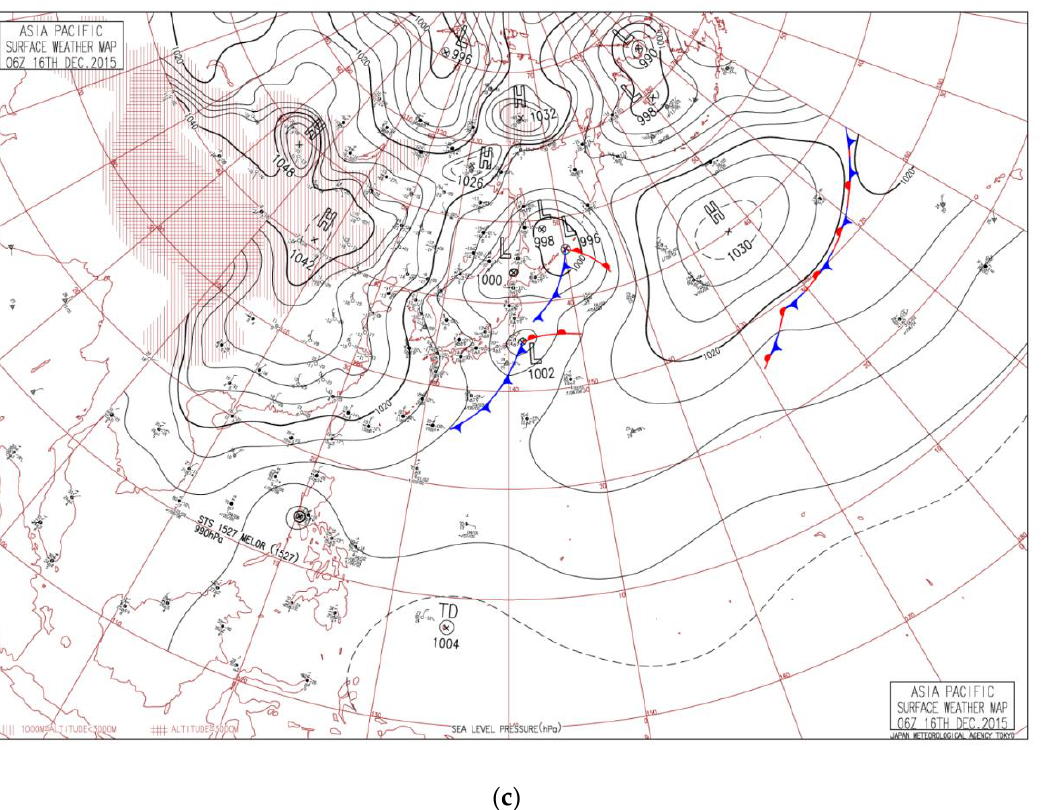
Figure 6. Surface weather map of East Asia: ( a ) at 20:00 LST on 17 January 2015; ( b ) at 20:00 LST on 5 February 2015; ( c ) at 14:00 LST on 16 December 2015. During period two, at 20:00 LST on 4 February, air pressure at the CHPS centre was 1056 hPa, located in Mongolia (49 ◦ N, 94 ◦ E) at BE2. It then moved toward the east–southeast. At 12:00 LST on 5 February, the maximum C PM in the Taipei metropolis 2.5 was 94.2 µ g · m − 3 (Figure 7b). At 20:00 LST, air pressure at the CHPS centre decreased to 1032 hPa, located in the Hubei Province (31 ◦ N, 115 ◦ E) at E2 (Figure 6b). It then moved further toward the east-southeast. At 08:00 LST on 6 February, air pressure at the CHPS centre decreased to 1030 hPa, located in the Jiangxi Province (29 ◦ N, 118 ◦ E) at AE2. It then moved slowly toward the east. At the three stages, apart from ∆ θ , T m , RH, WS, MH, VI, ∆ P , and d at E2 were not significantly different between BE2 and AE2 (Table 4). Thus, CHPS was at a specific location, where mean ∆ θ was − 7.4 ± 2.4 ◦ at E2. As shown in Figure 8b, the back trajectories of air masses ended at 12:00 LST on 5 February in Taipei. Therefore, the observed event was related to the long-range transport of PM over Yangtze River Delta (YRD), which was closely linked with the specific location of CHPS. As shown in Figure 9b, the exponent was greater than one in YRD. In addition, the AOD 3km value was greater than three in YRD. The Terra satellite passed over YRD at 10:16–10:17 LST, and the Aqua satellite passed over YRD at 13:33–13:34 LST, 4 February 2015, while the long-range transport of PM was over YRD. From these results, aerosol levels were high in ( a ) YRD, which supported fine PM